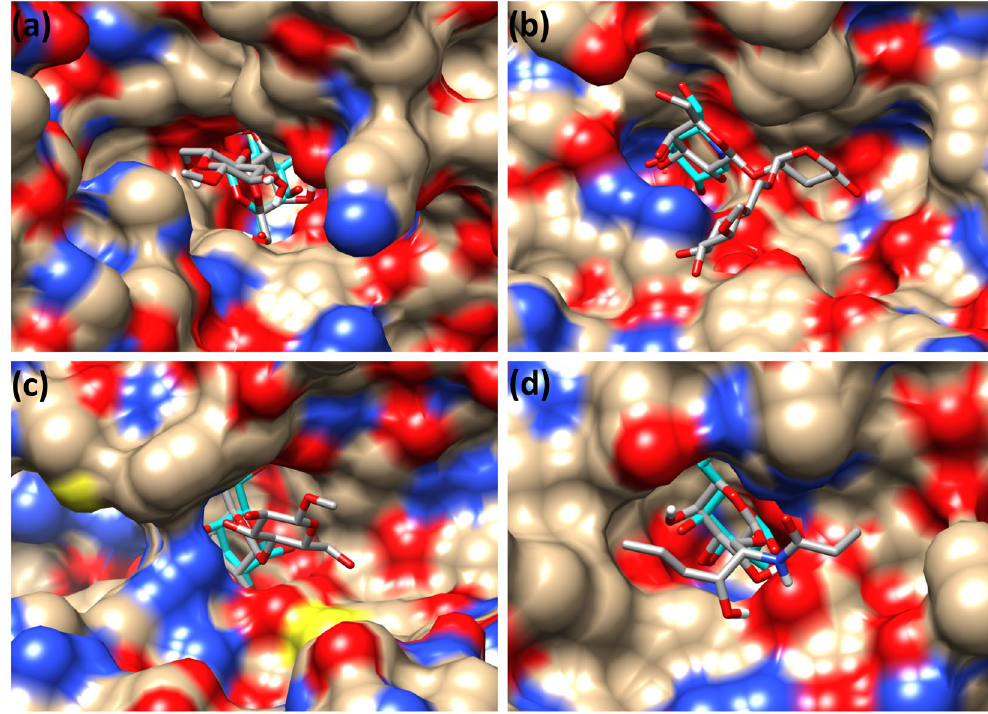
Figure 3. Best docked conformers of selected β -D-galactosides in representative β -galactosidase structures. Docking with Vina-Carb was contrasted with co-crystal ligands for β -galactosidases issued from different GH families: ( a ) 1-methyl- β -lactoside = DGalpb1–4DGlcp-OMe (GH1, PDB ID: 1UWR), ( b ) xyloglucan trisaccharide derivative (L-OMe) = DGalpb1–2DXylpba1–6DGlcp-OMe (GH35, PDB ID: 4DIJ), ( c ) 1-methyl- β -lactoside = DGalpb1–4DGlcp-OMe, (GH42, PDB ID: 3TTY) and ( d ) DGalp-Cerebroside-derivative with truncated aliphatic chains (GH59, PDB ID: 3ZR6). The co-crystal ligands are shown in cyan